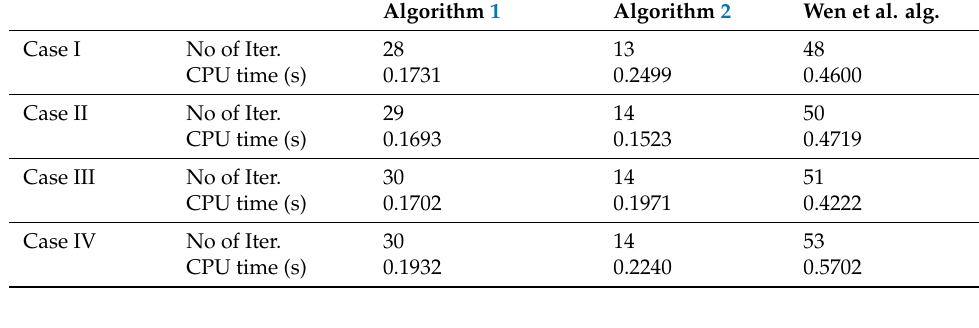
Algorithm 3.1 Algorithm 3.4 Wen et al. alg.